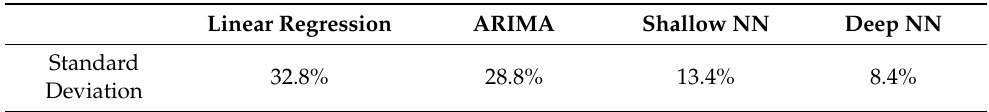
Table 7. Standard deviation of the difference between the mean average percentage error on the test set and on the training set, under a polynomial degree of three. Linear